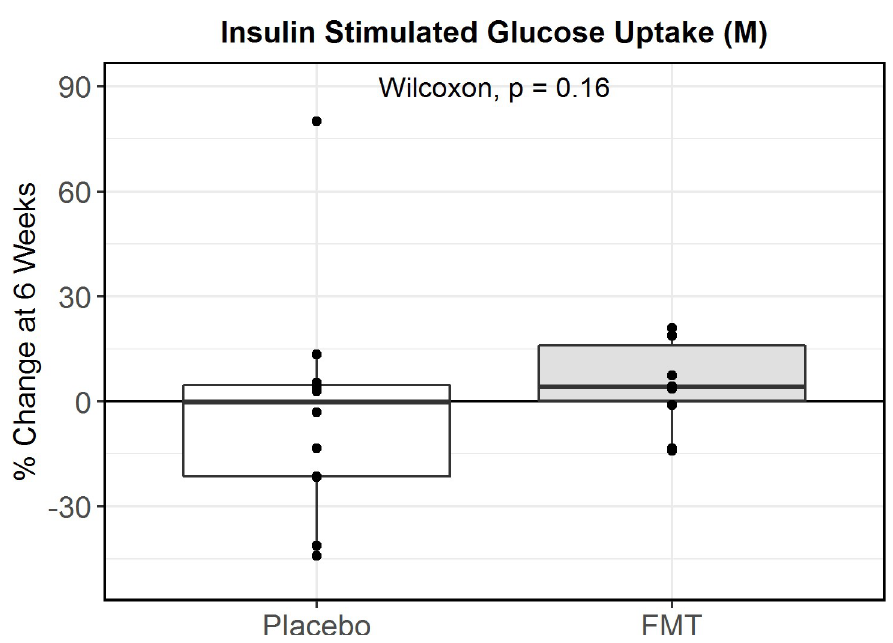
Fig 2. Boxplot of percentage change in insulin sensitivity in fecal microbiota transplantation (FMT) and placebo groups from baseline to 6 weeks. Insulin-stimulated glucose uptake (M value) was assessed by hyperinsulinemic euglycemic clamp as a measurement of insulin sensitivity.